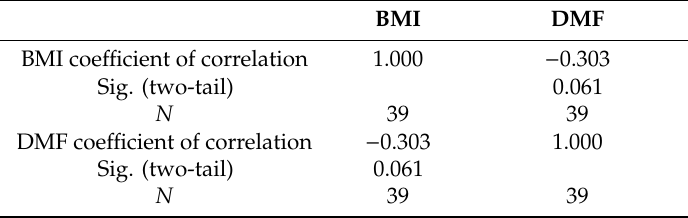
Table 15. Data related to the correlation between BMI and DMF in patients a ff ected by deepbite. BMI DMF BMI coe ffi cient of correlation Sig.